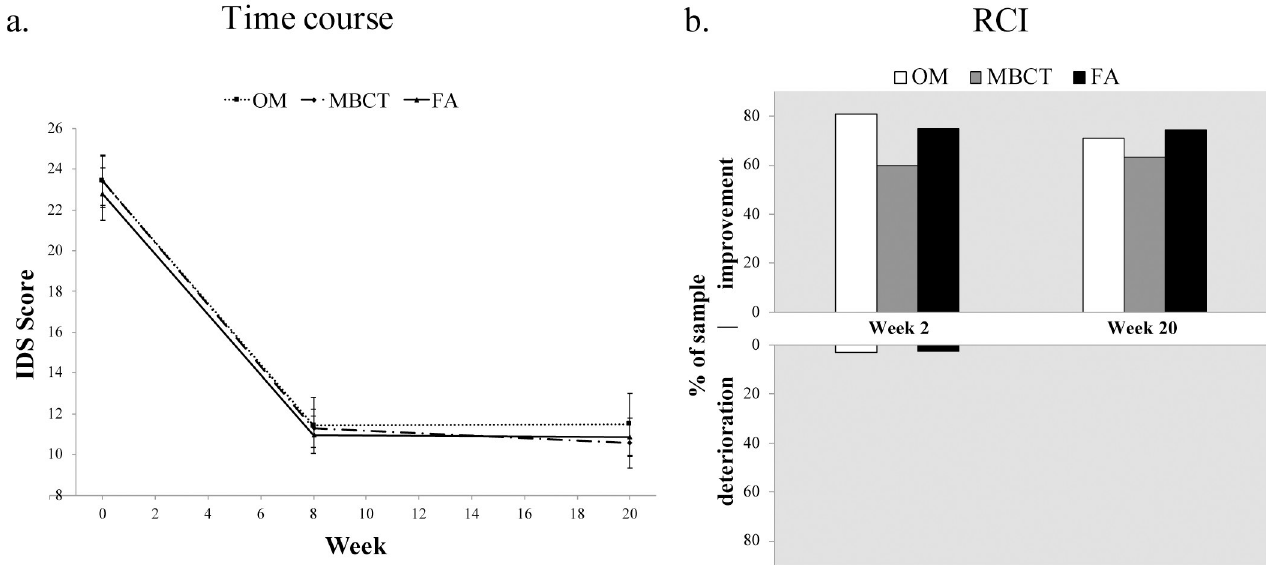
Fig 2. Differential treatment effects and clinically significant change in depression (IDS) for all three treatments over time. (a) Group means (symbol) and standard error (error bars) at baseline (week 0), post-treatment (week 8) and follow-up (week 20) in intent-to-treat regression analysis ( n = 104). (b) Reliable change index (RCI) at each timepoint relative to baseline scores. Upward and downward bars signify % of each treatment sample showing clinically significant improvements and deteriorations, respectively. Percent of sample with no reliable change is not shown (see S1 Appendix).